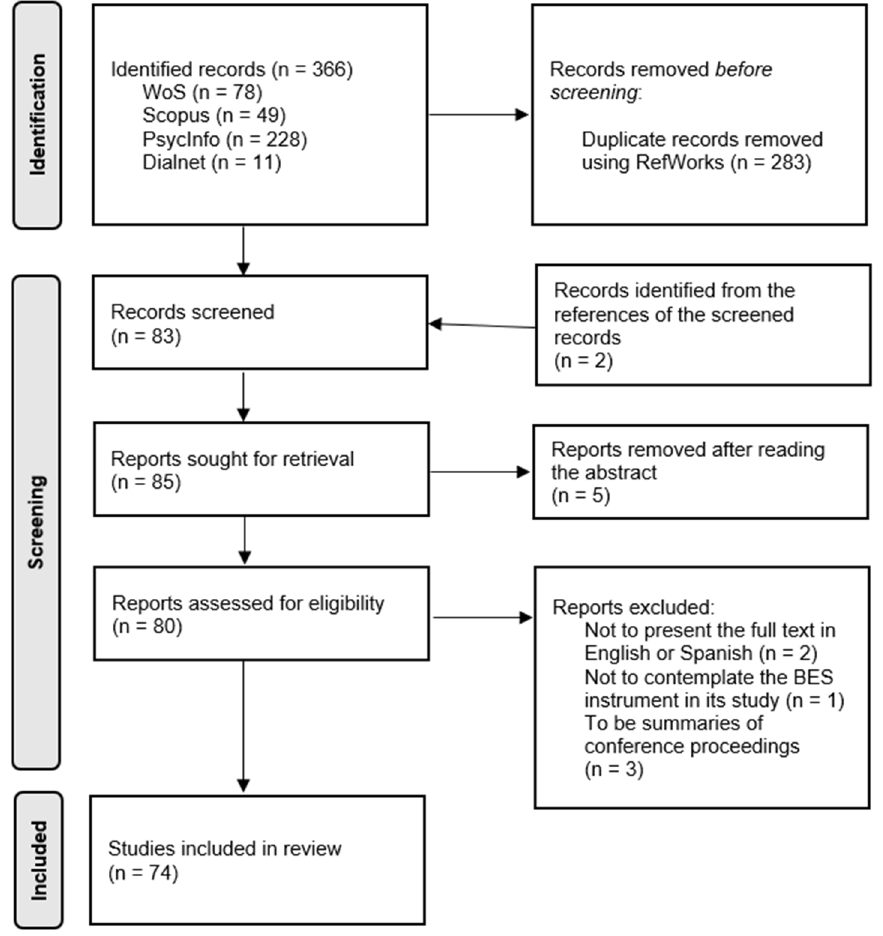
Figure 1. PRISMA flow diagram of article selection process.